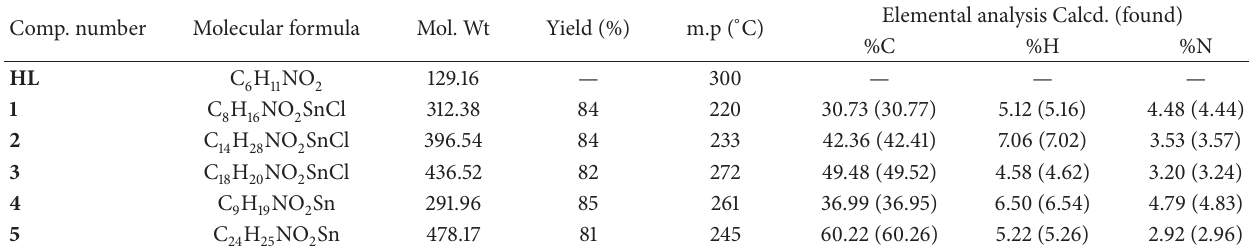
Table 1: Physical data of organotin complexes 1–5 .